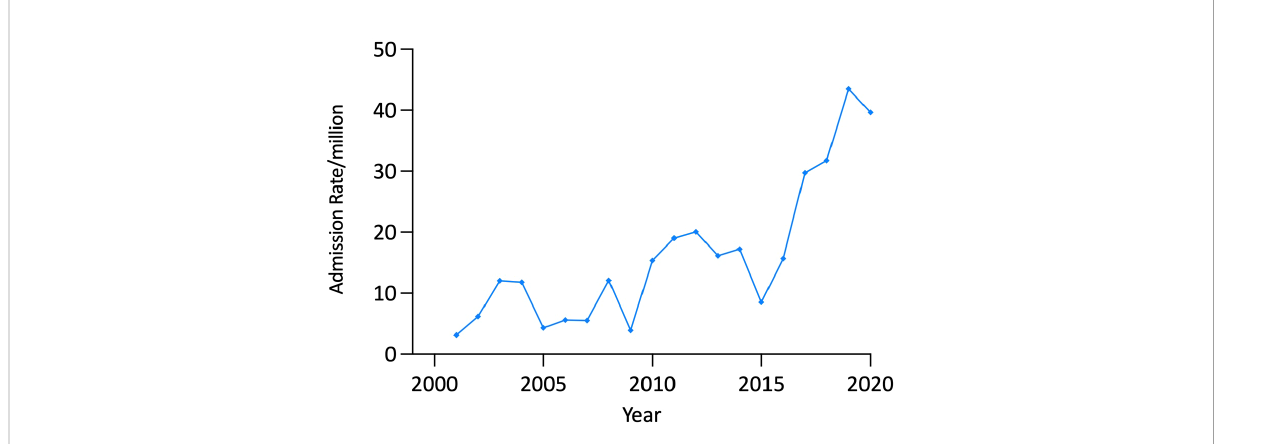
FIGURE 5 Adrenal crisis admission rate, females aged 20-24 years by year.